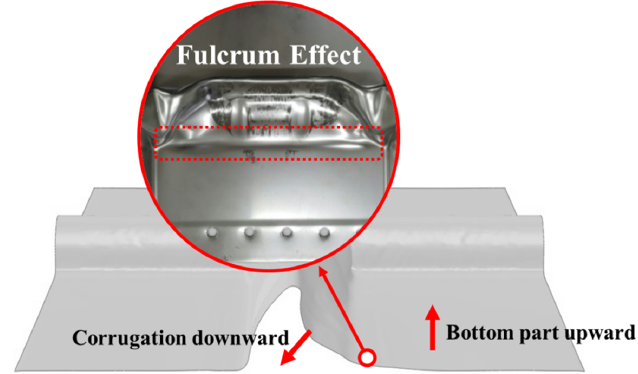
Figure 11. Schematic diagram of hinge-shaped part playing a role of a fulcrum in primary barrier.